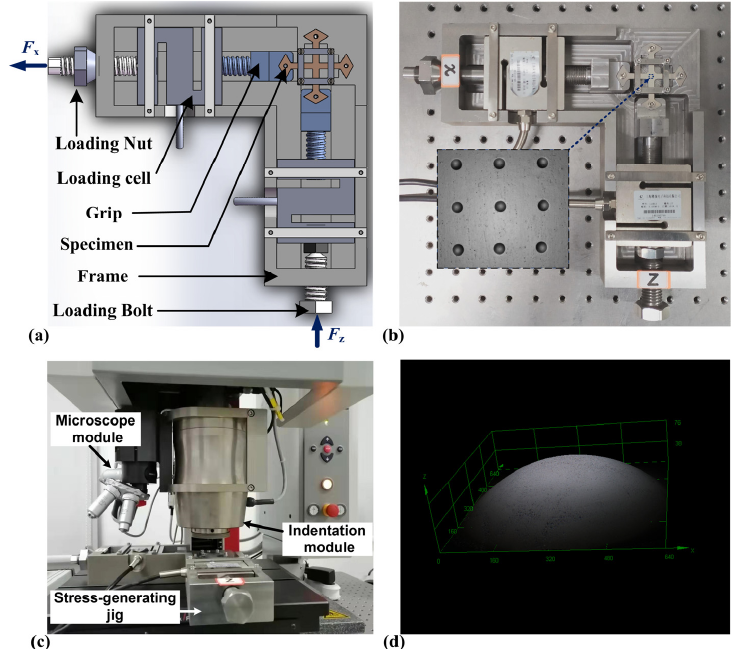
Figure 7. (a) The design diagram of the biaxial stress-generating jig; (b) the manufactured stress-generating jig and the distribution of indentation points in the central area of the cruciform specimen; (c) the Zwick ZHU2.5 universal hardness testing system employed to carry out indentation tests; and (d) the optical micrograph of the crown part of the spherical indenter used for indentation tests.